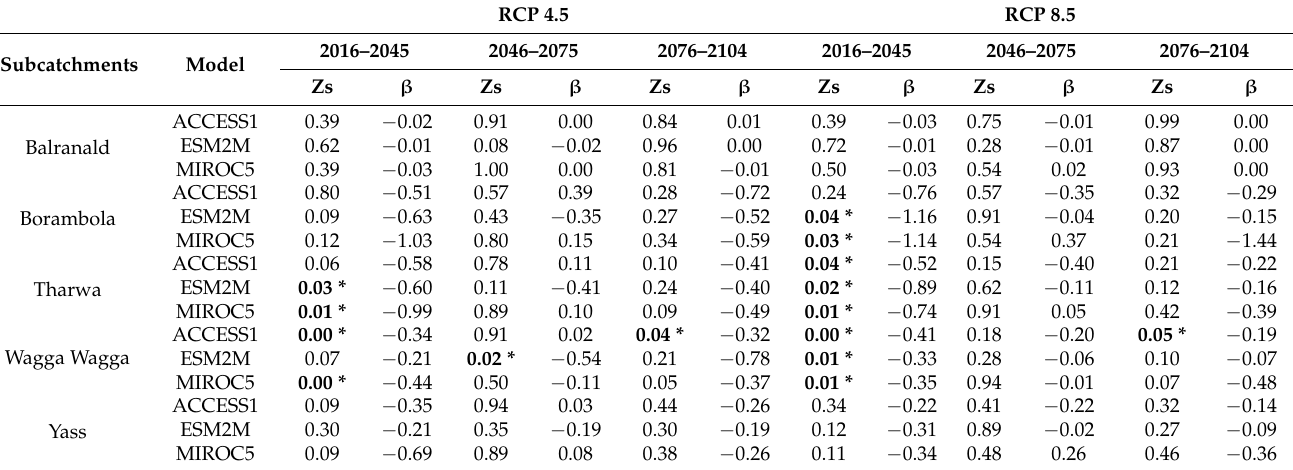
Table 11. Trend analysis of annual runoff at sub-catchments of Murrumbidgee River basin under RCP 4.5 and RCP 8.5